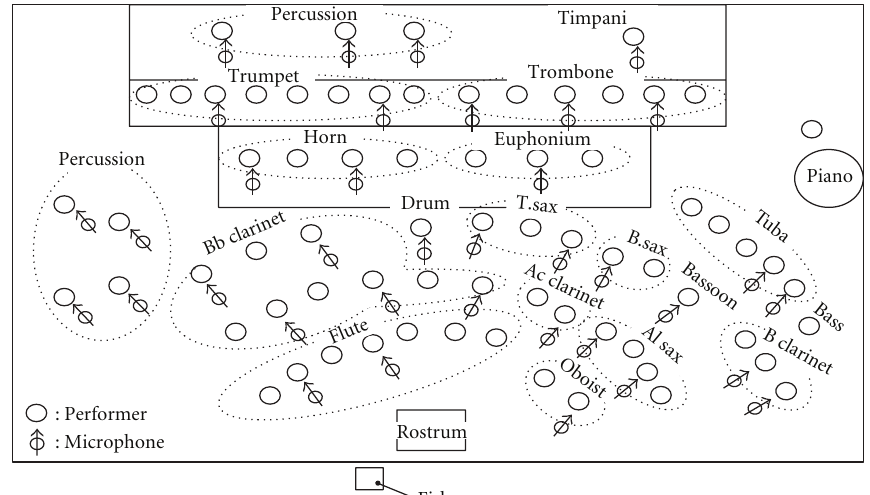
Figure 14: Microphone and camera positions.